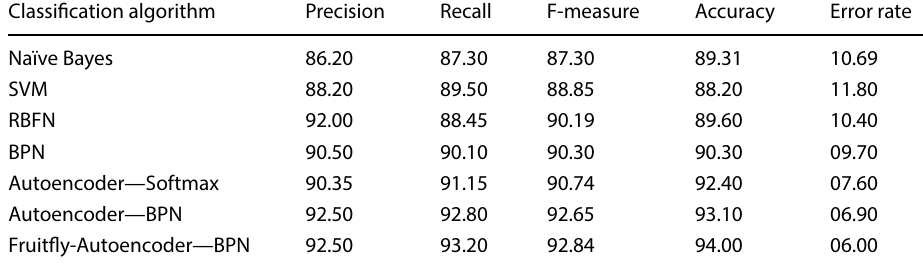
Classification algorithm